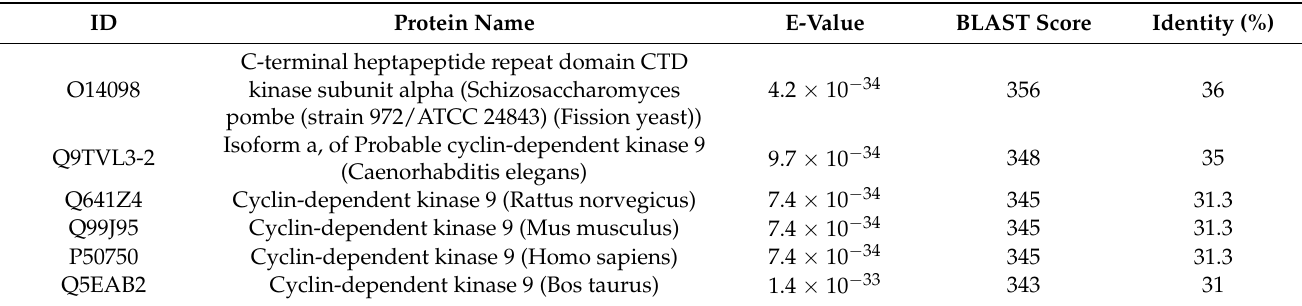
Table 1. BLAST results showing identical proteins to the Ld CRK12. The best template is selected based on the E-value, sequence identity, BLAST score, and availability of a 3D